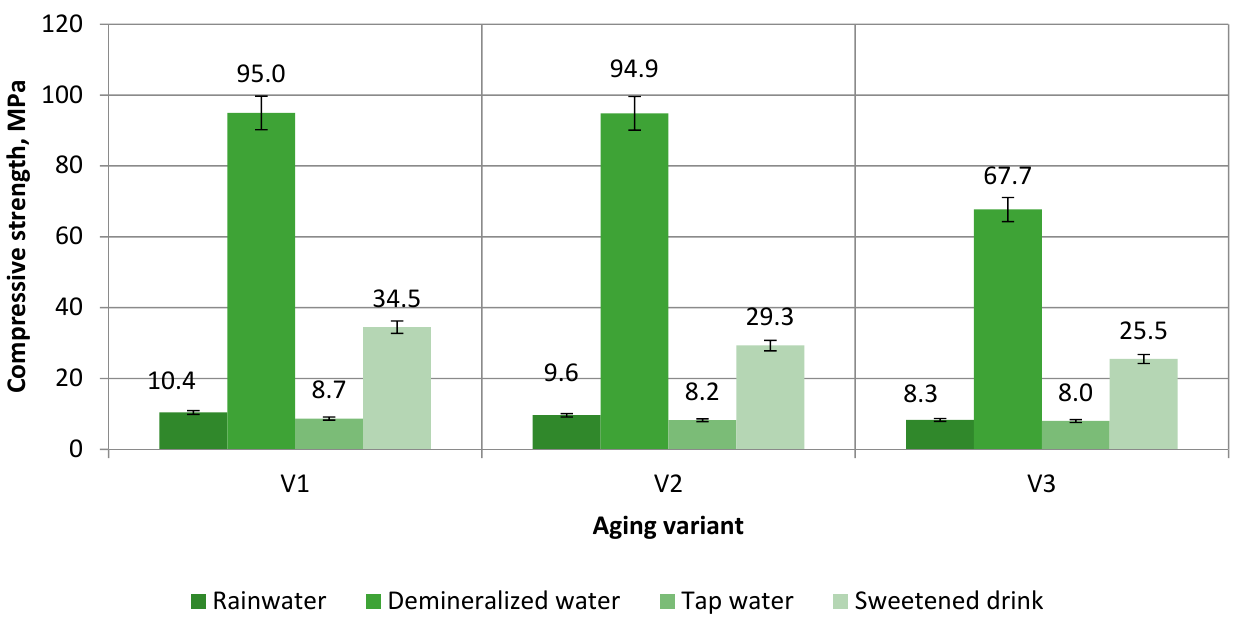
Figure 6. Compressive strength of Epidian 57/PAC/1:1 epoxy compound samples aged in various aqueous environments.